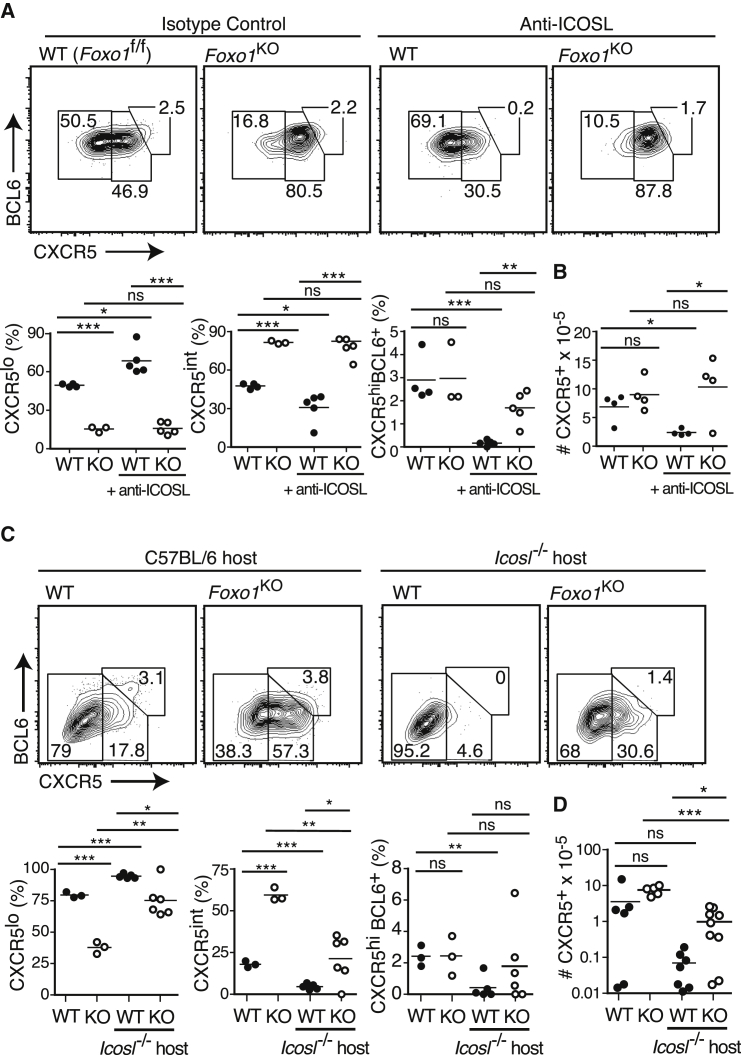
Tfh Differentiation in the Absence of FOXO1 Is Independent of ICOSL(A and B) WT or Foxo1KO OTII cells were transferred into CD45.1 hosts and mice were immunized with OVA plus adjuvant. Where indicated, mice were treated with blocking anti-ICOSL. (A) The percentages of CXCR5lo, CXCR5int, and CXCR5hiBCL6+ cells and (B) total number of CXCR5+ (including both the CXCR5int and CXCR5hi populations) of WT or Foxo1KO OTII cells is shown. One of four representative experiments.(C) The percentages of CXCR5lo, CXCR5int, and CXCR5hiBCL6+ cells of WT or Foxo1KO OTII cells in WT or Icosl−/− hosts days 4 post immunization. Data are representative of two independent experiments.(D) Numbers of WT or Foxo1KO CXCR5+ (including both the CXCR5int and CXCR5hi populations) OTII cells days 4 post immunization from WT or Icosl−/− hosts plotted on a log scale. Data are pooled from two independent experiments.